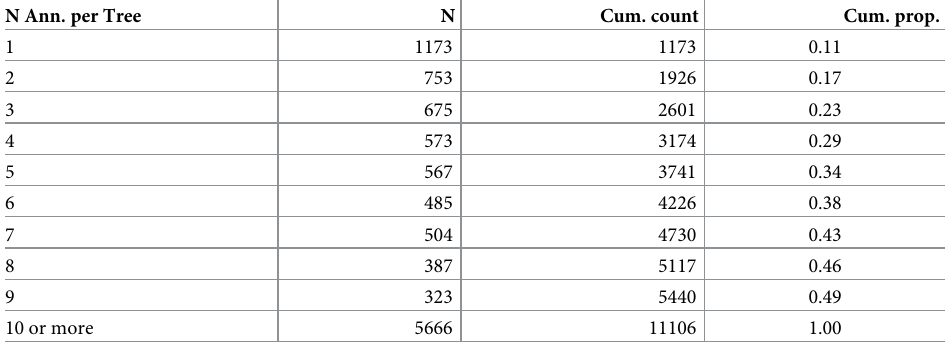
Table 8. Distribution of trees per number of functions (annotations) in PANTHER. At least 50% of the trees used in this paper have 10 or more annotations per tree. N Ann. per Tree N Cum. count Cum.